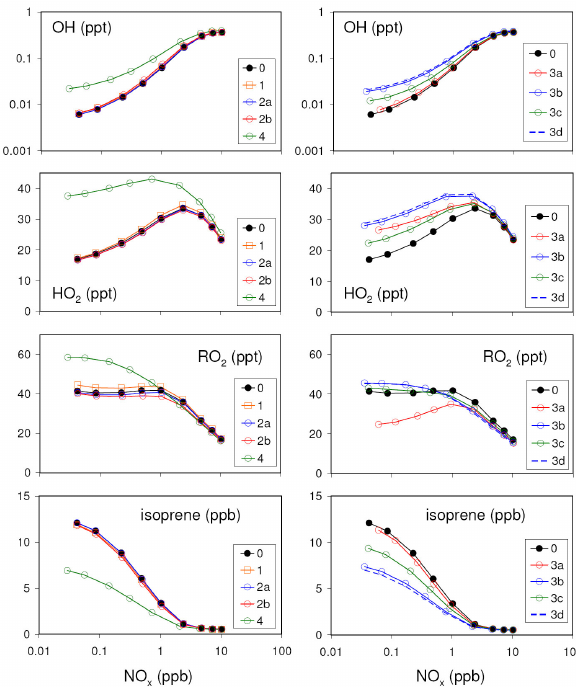
Fig. 3. Simulated mixing ratios of OH, HO 2 , RO 2 and isoprene as Figure 3. Simulated mixing ratios of OH, HO 2 , RO 2 and isoprene as a function of NO x mixing 2 a function of NO x mixing ratio, using MCM v3.1 (Mechanism 0) ratio, using MCM v3.1 (Mechanism 0) and the mechanism variants described in Table 1. All 3 and the mechanism variants described in Table 1. All values are values are daytime averages on the second day of the simulations, calculated from 06:00 to 4 daytime averages on the second day of the simulations, calculated 18:00 local time in the model. 5 from 06:00 to 18:00 local time in the model.